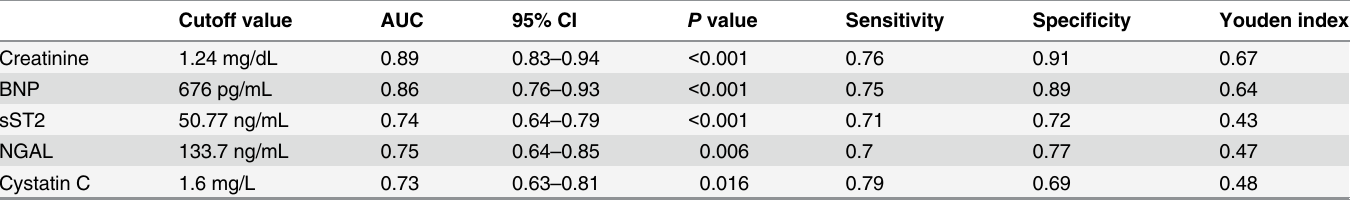
Table 4. Receiver operating characteristic curve analysis of creatinine and the biomarkers of heart failure and renal dysfunction in predicting acute kidney injury.